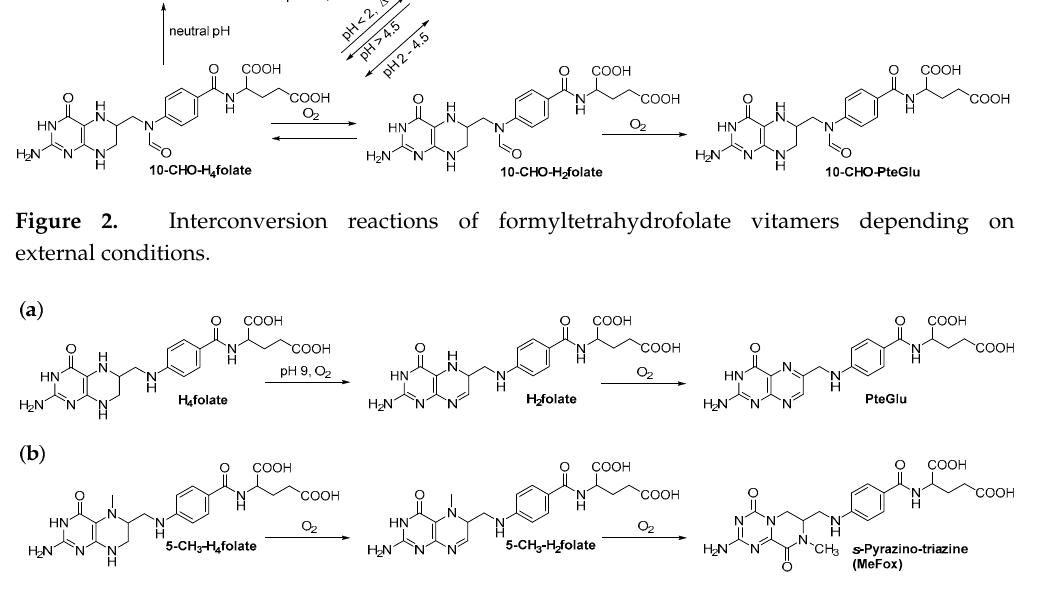
Figure 3. Oxidation reactions of selected folate vitamers: ( a ) oxidation reaction of H 4 folate, ( b ) oxidation reaction of 5-CH 3 -H 4 folate.